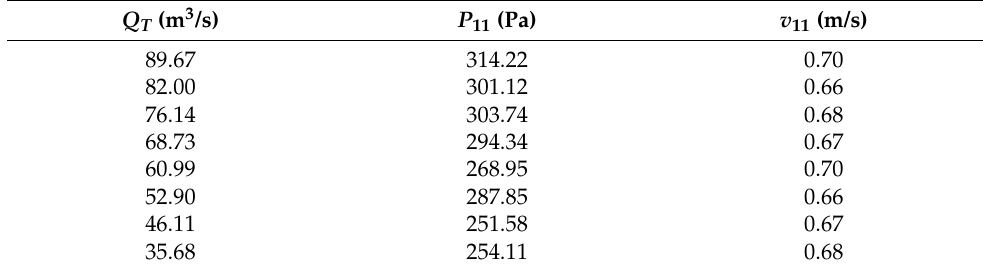
Table 6. Manifold’s velocity and pressure, high-pressure